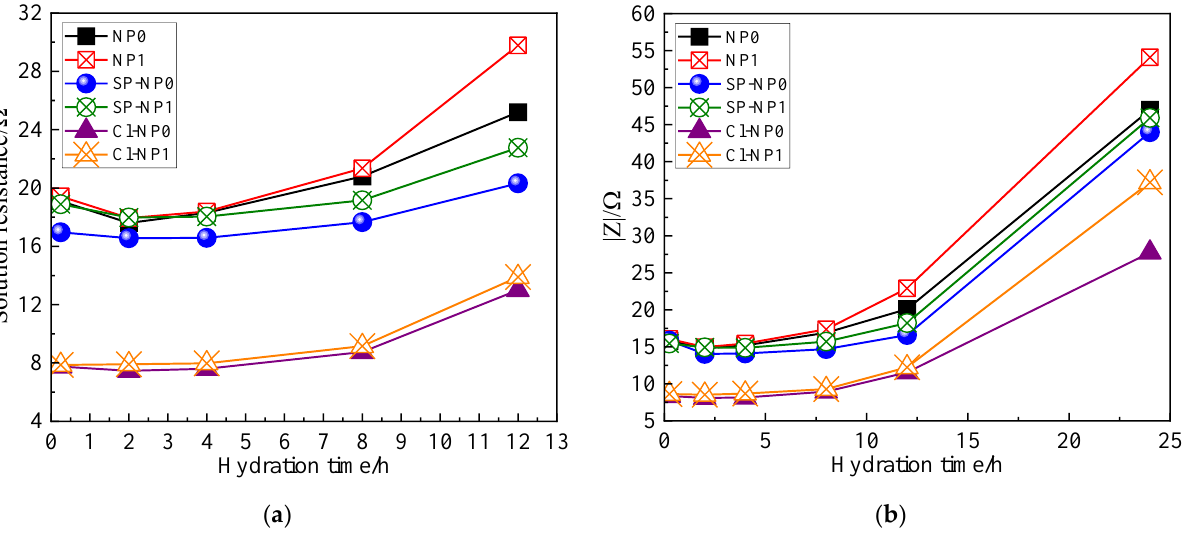
Figure 9. The variations of pore solution resistance and impedance modulus in cement paste. ( a ) Pore solution resistance ( b ) Impedance modulus.